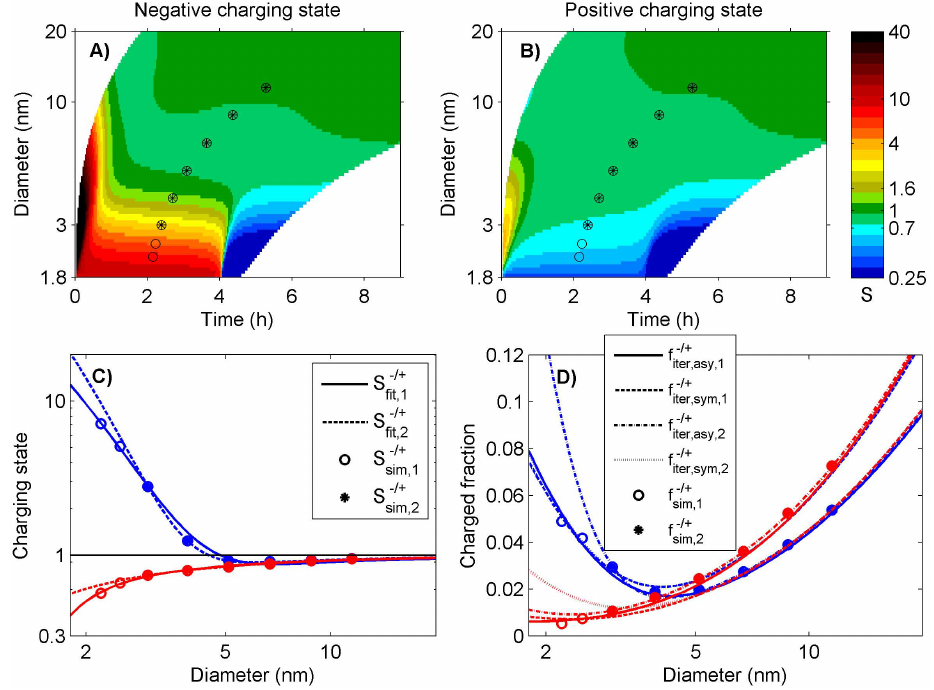
Fig. 4. The upper panels depict the aerosol charging state of the example simulation as a function of time and diameter with the colours representing the value of the negative (A) and the positive (B) charging state. The lower panels depict the charging state (C) and the charged fraction (D) as a function of diameter obtained by following the centre of the mode. In the lower panels, the blue and red colours indicate the negative and the positive charging state or charged fraction, respectively. The circles denote the simulated values and the lines denote the iterated (C) or the fitted (D) values. In the legends, “asy” and “sym” denote whether asymmetric or symmetric small ion concentrations have been used, respectively, and numbers 1 and 2 indicate whether the data from DR 1 (2.2–11.5nm) or DR 2 (3–11.5nm), respectively, had been used. In (D) , in the sizes > 5nm, the upper (lower) group of lines almost on top of each other include the lines denoting f − iter,sym ) . In (D) , in the sizes < 5nm, the upmost blue line denotes the f − and f + ( f − and f + , whereas the other three blue lines iter,asy iter,asy iter,sym iter,asy,1 are almost on top of each